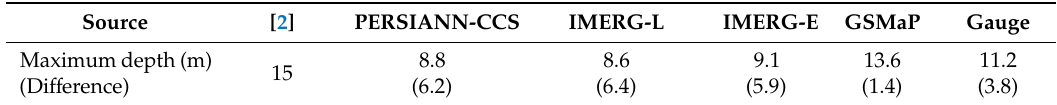
Table 4. Comparison of estimated flood depth to reference flood depth using the hydrological model using di ff erent satellite precipitation products and rain gauge